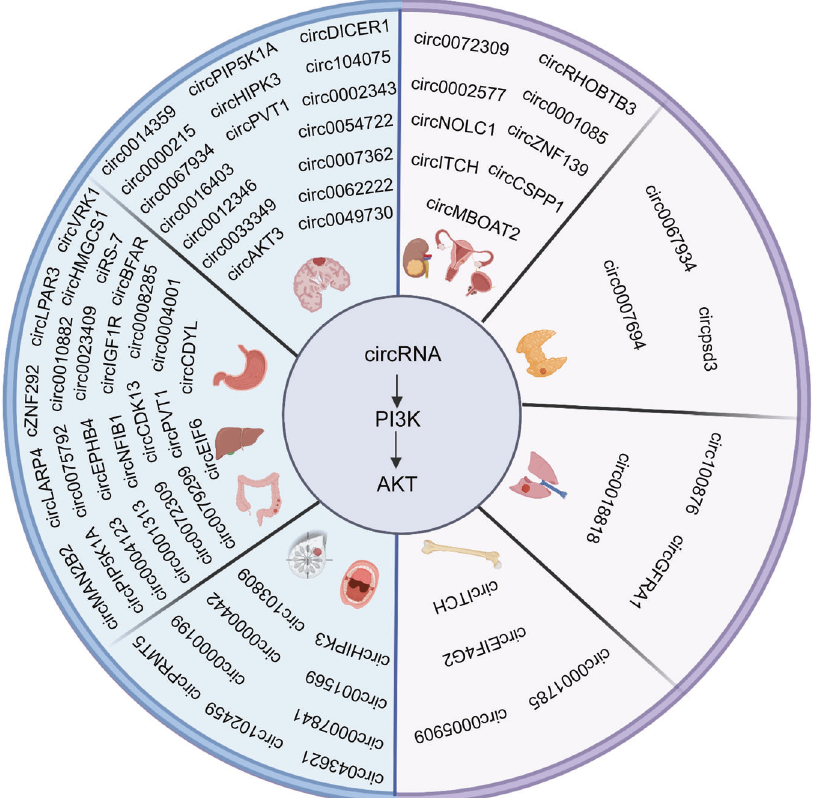
Fig. 1 CircRNAs interact with the PI3K/AKT pathway to regulate cancer progression. Image created with BioRender (https://biorender.com/)